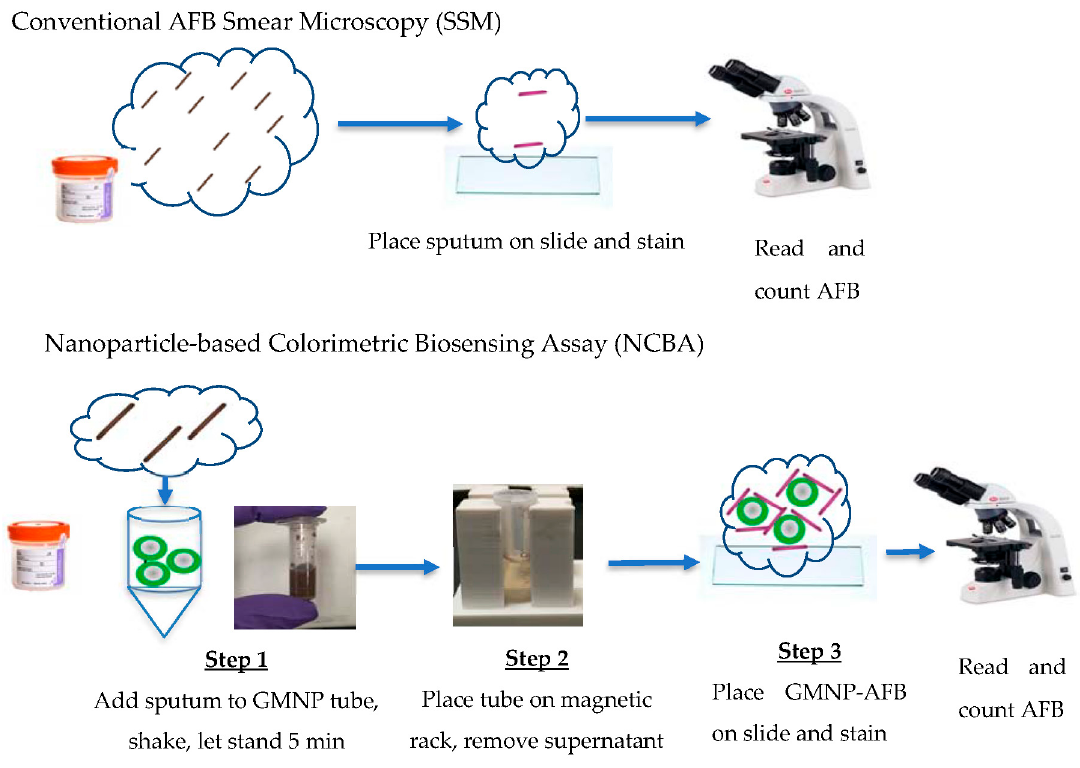
Figure 1. Schematic representation of sputum smear microscopy (SSM) (top) and nanoparticle-based colorimetric biosensing assay (NCBA) (bottom) approaches.